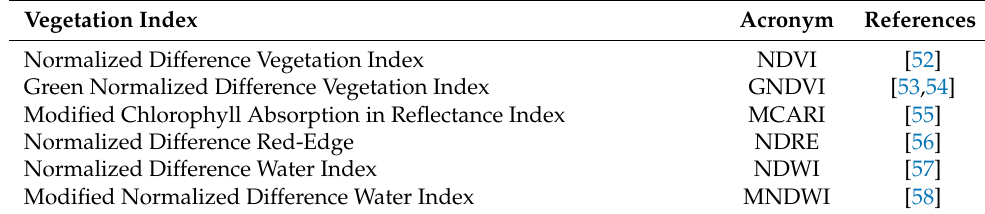
Table 3. Vegetation indices applied to the time-series image